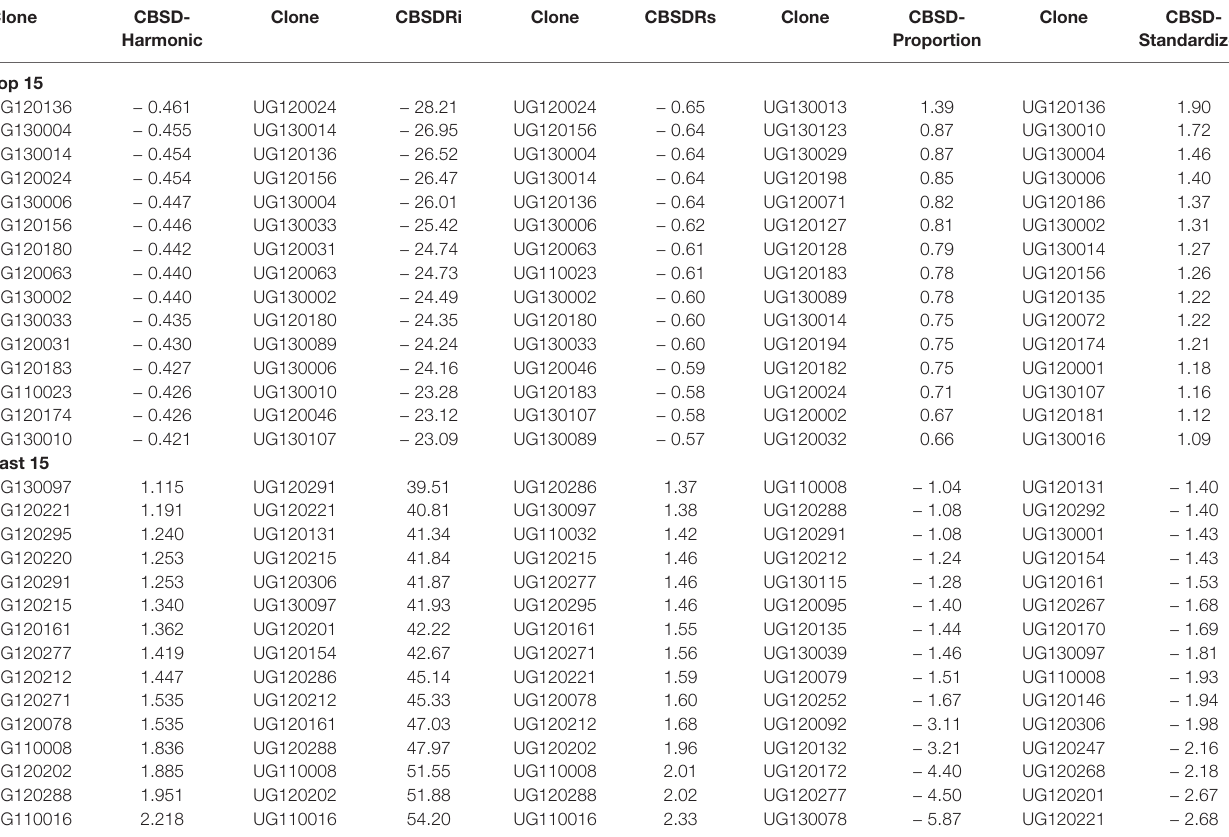
TABle 3 | Ranking of the top 15 and last 15 clones based on best linear unbiased predictions (BLUPs). Clone CBSD-